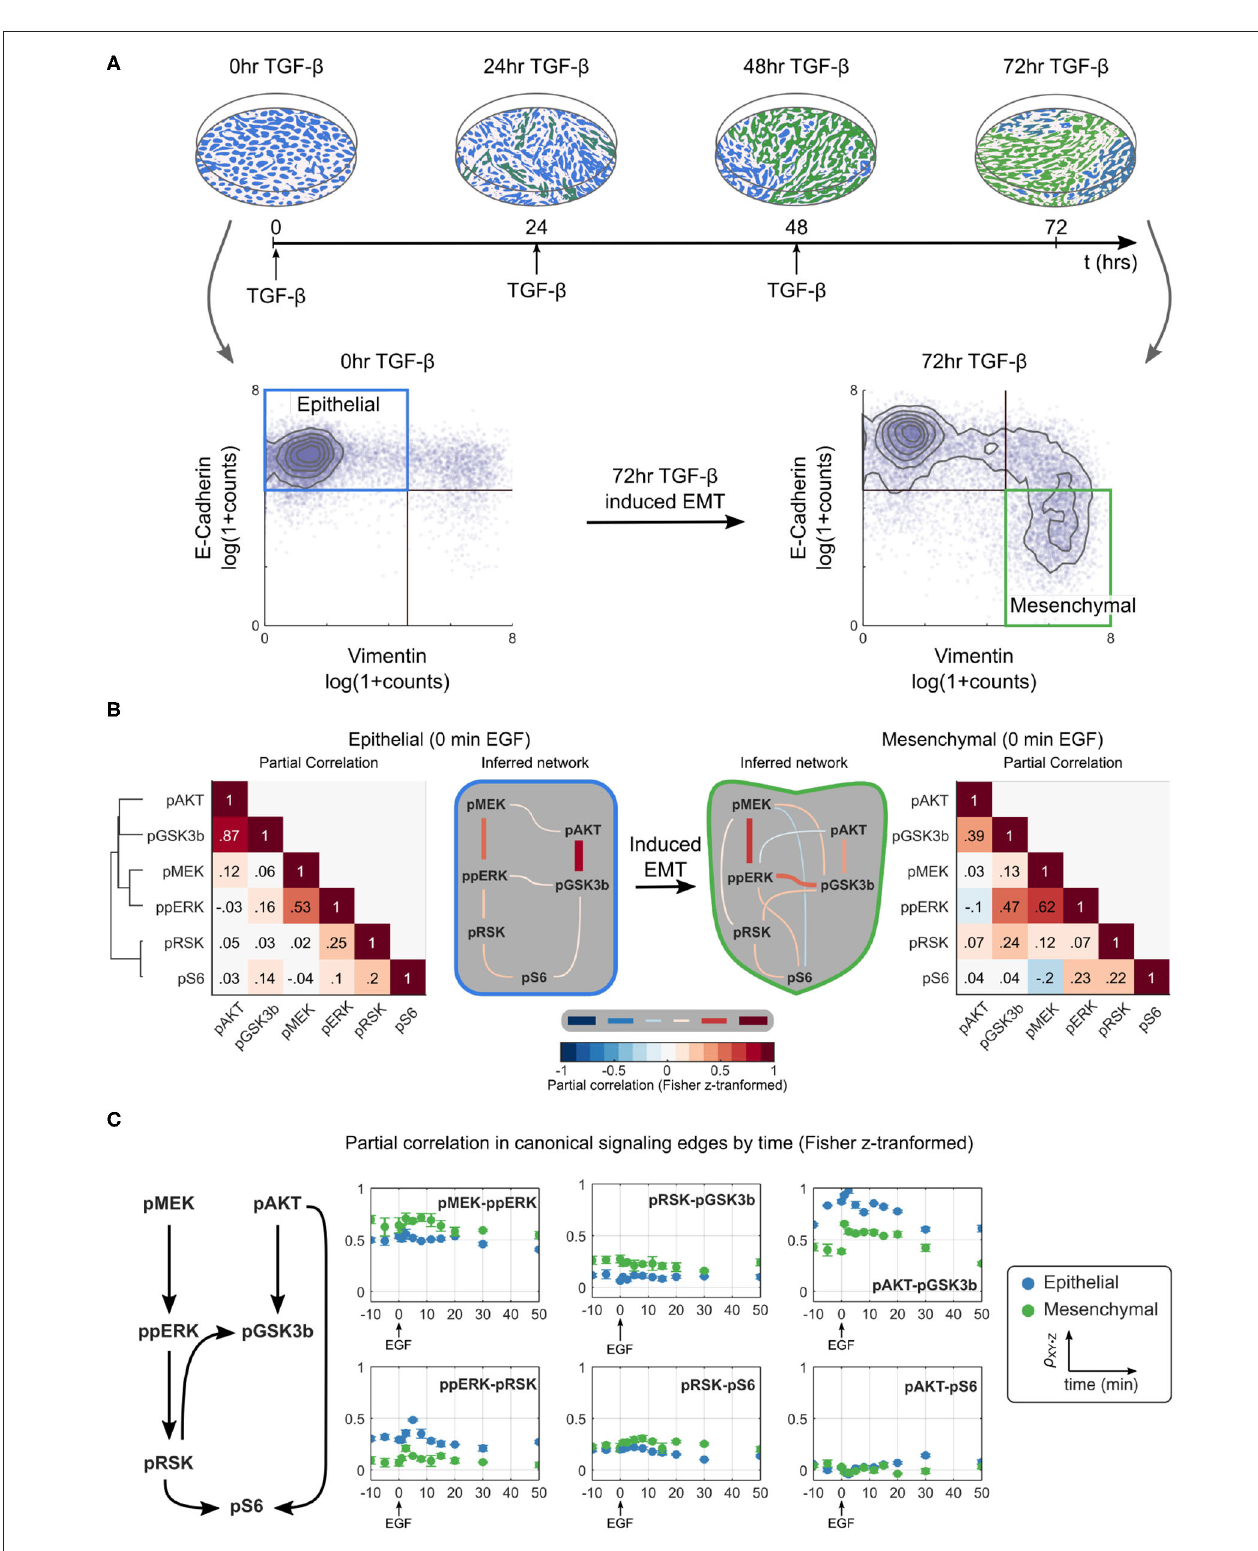
FIGURE 2 | Partial correlation-based network inference suggests that the ERK/AKT signaling network is significantly rewired during EMT. (A) Overview of an EMT model (top) including an illustration of the visual phenotype and a molecular definition of epithelial and mesenchymal cells measured by mass cytometry at various